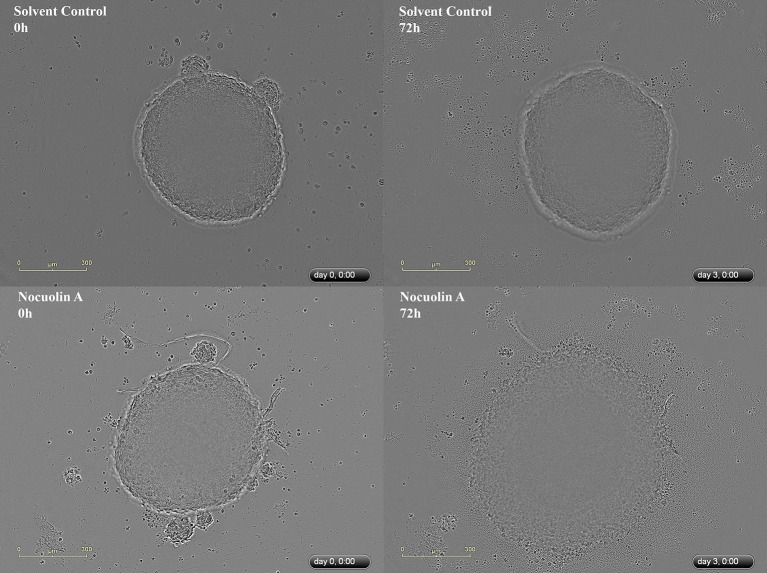
Representative IncuCyte images of HCT116wt spheroids. Top image represents a spheroid in the beginning (0 h) and at the end of the experiment (72 h), without exposure to NocA while the bottom images represent a spheroid exposed to 20 μM of NocA. Quantitative analysis is shown on Supplementary Figure 4 derived from 3 independent experiments in triplicates.